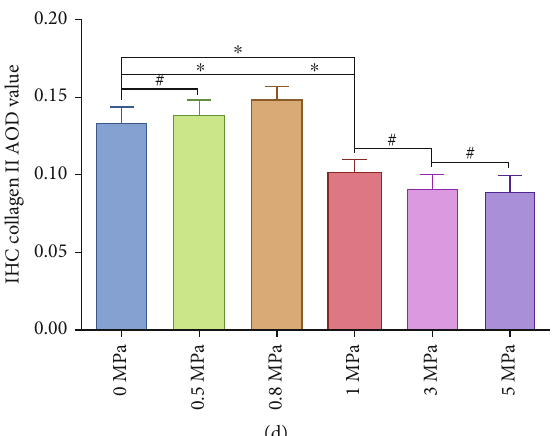
Figure 5: E ff ect of hydrostatic pressure on synthesis of collagen type II of the rabbit notochordal NP and fi brocartilaginous inner AF: (a) collagen type II IHC staining of the notochordal NP under graded hydrostatic pressure (200x); (b) statistic analysis of IHC collagen type II AOD value of the notochordal NP under graded hydrostatic pressure; (c) collagen type II IHC staining of the fi brocartilaginous inner AF under graded hydrostatic pressure (200x); (d) statistic analysis of IHC collagen type II AOD value of the fi brocartilaginous inner AF under graded hydrostatic pressure. ∗ P < 0 : 05 . # P > 0 : 05 . Scale bar = 100 μ